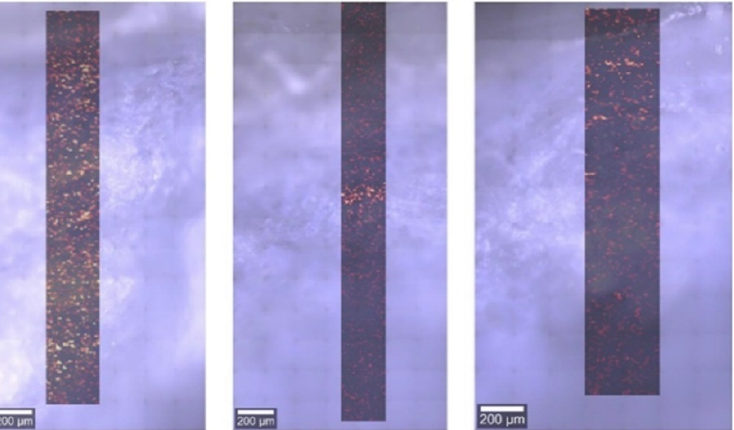
Figure 3. The representative Raman images for the cream with 3% taxifolin sample for each of Table 3. TXF was not observed for any of the recorded maps in cross-sections through the skin. Table 3. Results of patch testing with examined